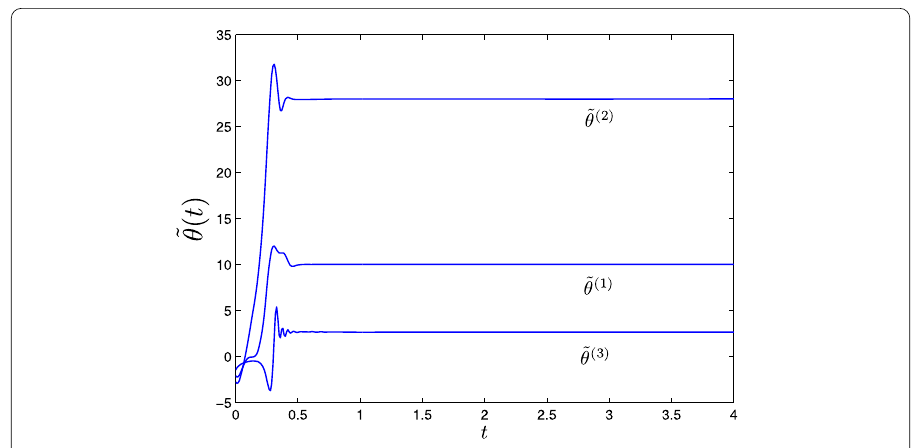
˜ θ ˜ θ (1) ˜ θ (2) ˜ θ (3) = ( , , ) T by adaptive feedback control with